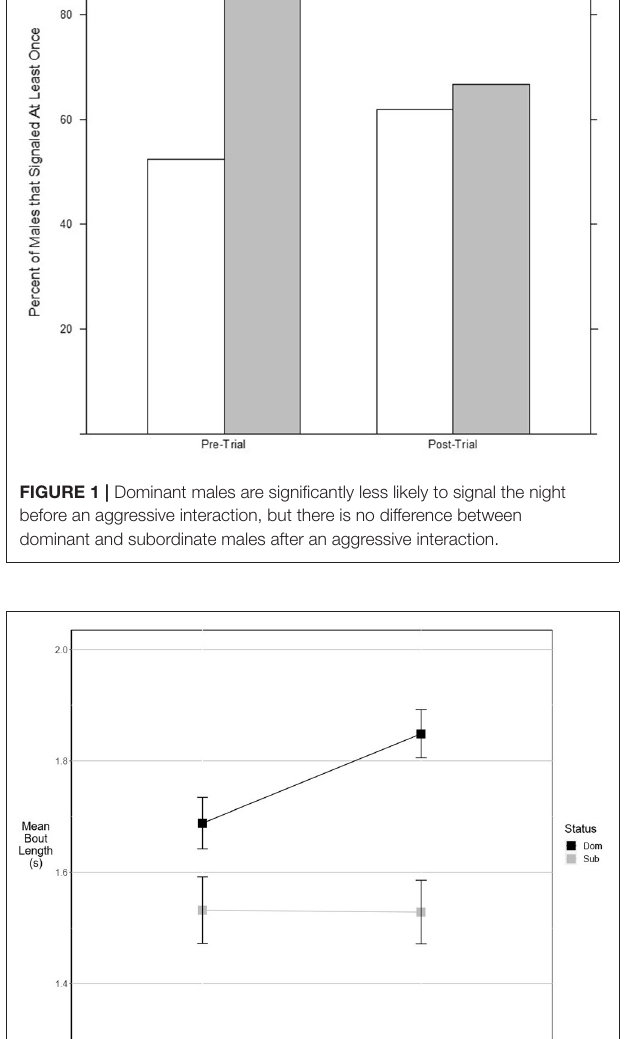
FIGURE 4 | Dominant males signal with higher amplitude than subordinate males. This margin is significant after an aggressive interaction. Graph of mean